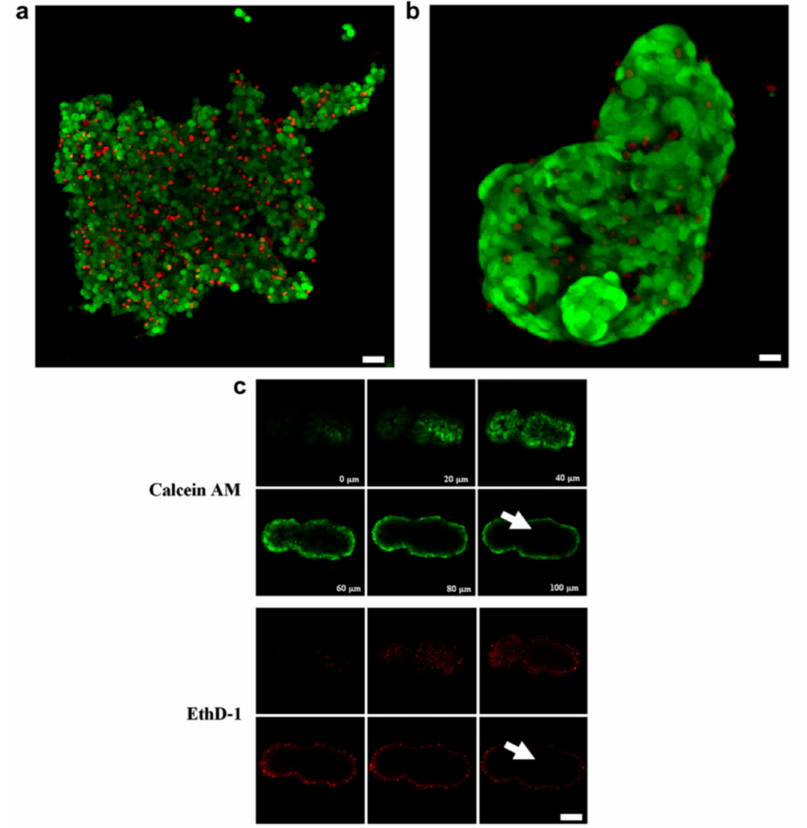
Figure 2. Ultrasound-formed HepG2 cell aggregates embedded in alginate retains viability and forms spheroids over time. Individual HepG2 cells are distinguishable in the initial aggregate ( a ) but after three days in culture membrane spreading and cell–cell connections forms a stable spheroid ( b ). Calcein AM and EthD-1 staining after 10 days in culture shows retained cell viability and poor dye penetration which is typical for larger 3D aggregates ( c , d ). Scale bars are 30 µ m in ( a ), 10 µ m in ( b ) and 20 µ m in ( c ). Reprinted with permission from